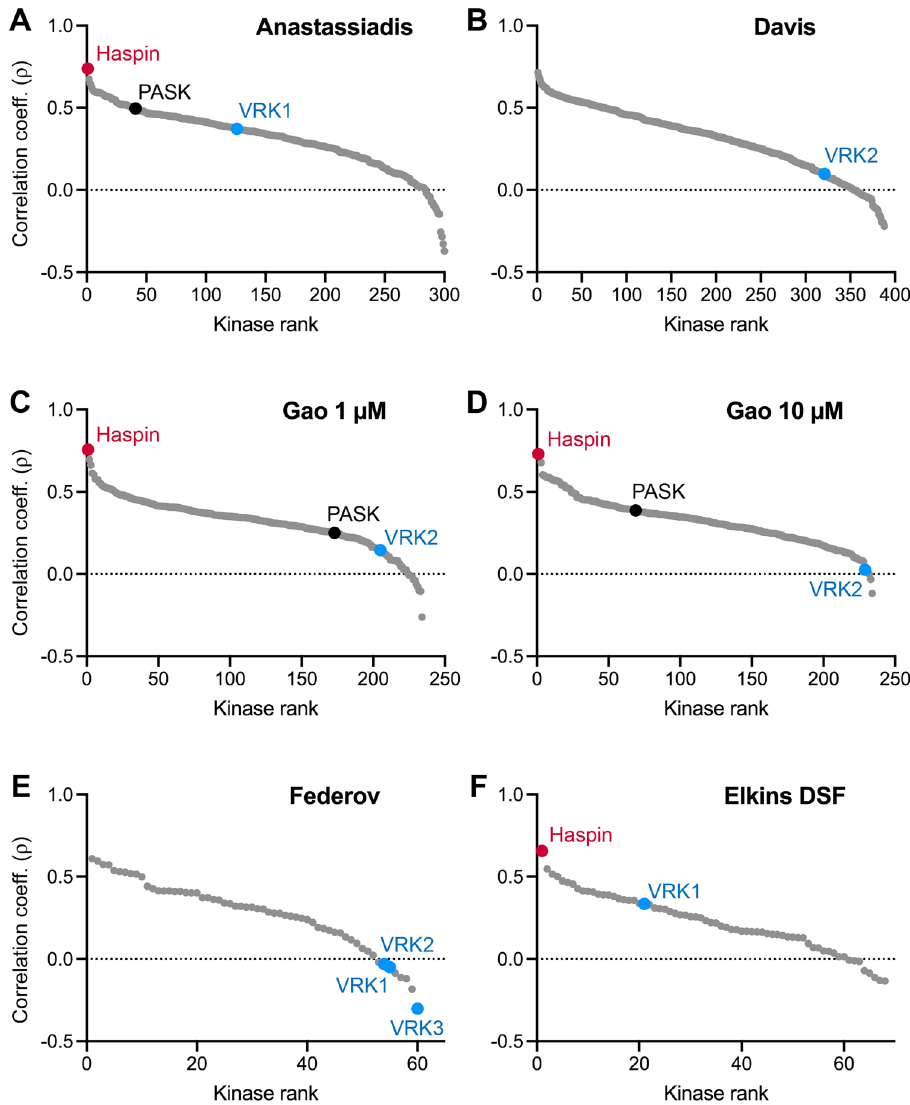
Figure 2. KiPIK screens for H3T3 kinase activity in mitotic HeLa cell lysates using the kinase profiling datasets of ( A ) Anastassiadis et al. 66 , ( B ) Davis et al. 68 , ( C , D ) Gao et al. 67 , ( E ) Federov et al. 69 and ( F ) the differential scanning fluorimetry (DSF) method of Elkins et al. 99 . Some results of the Elkins DSF screen were previously published 65 . The ranking of Haspin (red), VRK1, VRK2, VRK3 (blue) and PASK (black) are shown for all datasets in which they